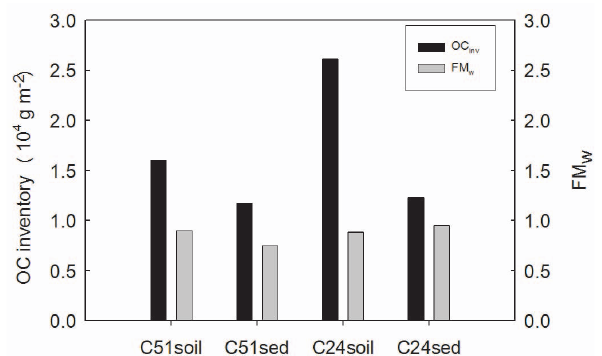
Fig. 6. Organic carbon inventory and FM w (see Sect. 2.6) at the eroding (soil) and depositional sites